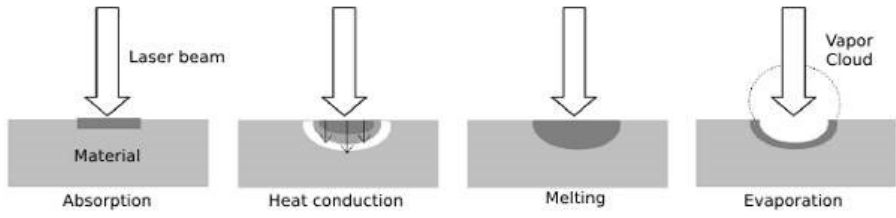
Figure 1. Thermal processes occurring in laser-material interaction